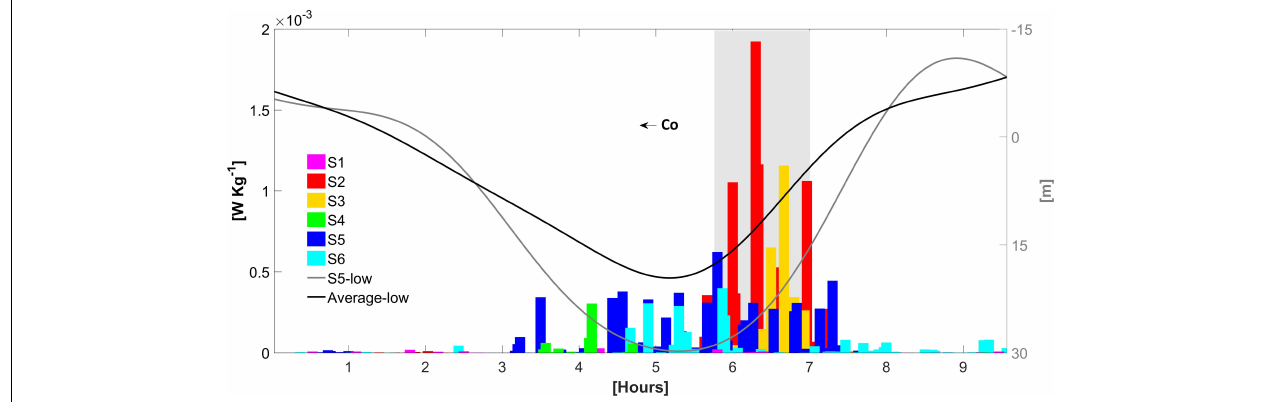
FIGURE 12 | The root-mean-square of the rate of turbulent mixing (in W Kg − 1 ) throughout the water column (left axis) in the course of the long-wave for each relevant 2-day segment (S1 to S6) on PIL200. The long-wave displacement (in meters, right axis) was computed as the difference between the depth of the undisturbed 20 ◦ C isotherm and the depth of this same isotherm low-pass filtered of 3 h, for the wave described in S5 (gray line) and the average for all sections (black line).